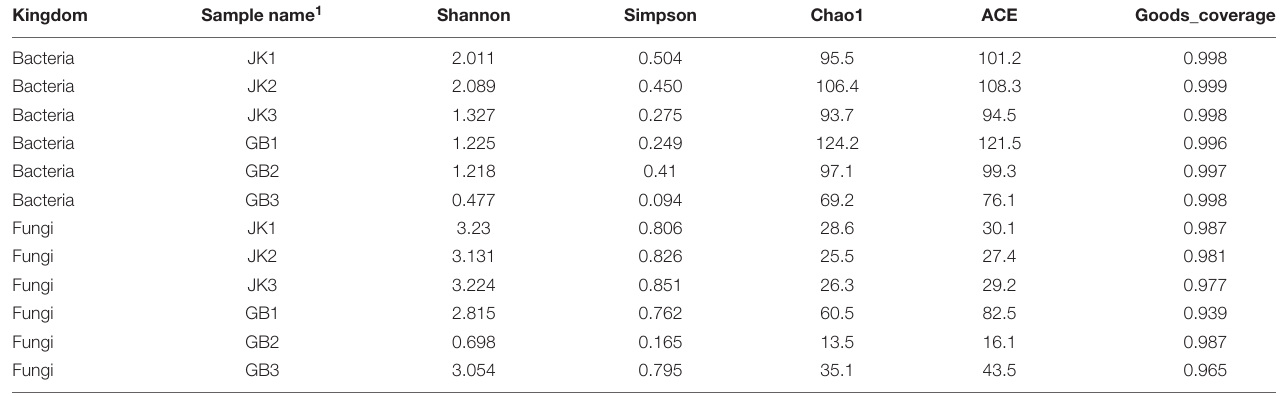
TABLE 3 | Alpha diversity indexes of phyllosphere microbial